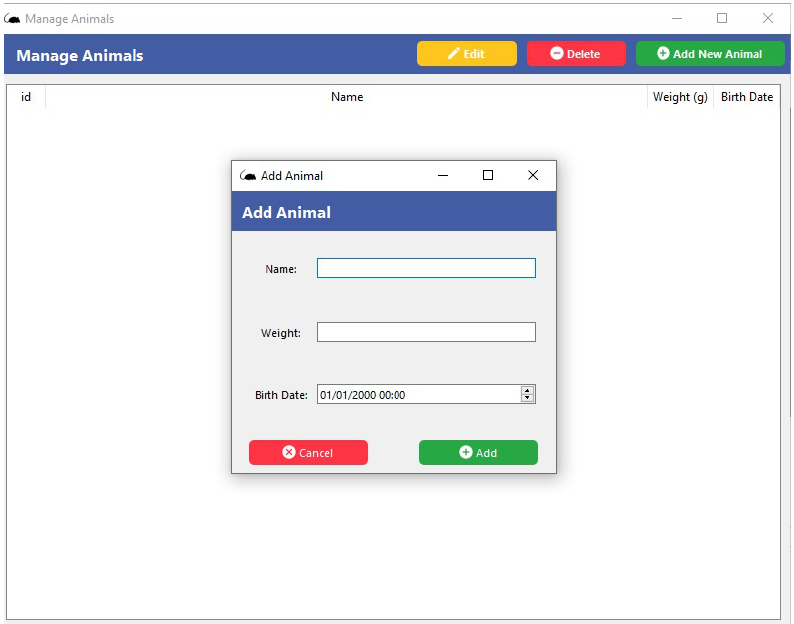
Figure 7. Screen of the Animal function of the supervisory software of the behavioral box.